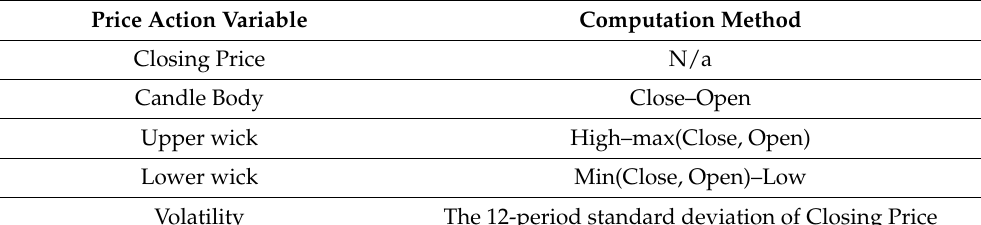
Table 1. Price Action